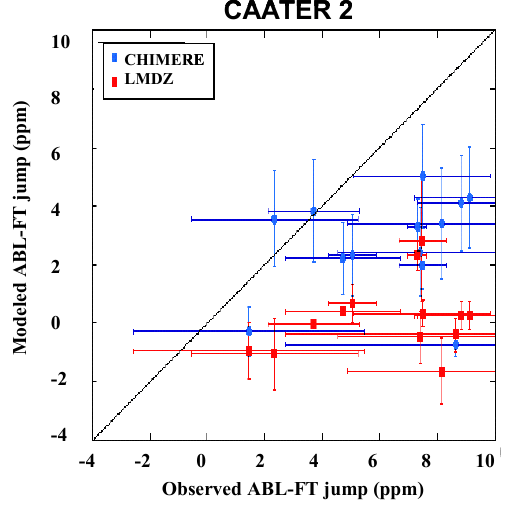
Fig. 6. Comparison of the modelled ABL-FT jumps from LMDZ- ORCHIDEE and CHIMERE-ORCHIDEE to the observed jumps for CAATER 2. Points represent the mean jump for each profile and bars represent the associated ± 1- σ standard deviation from ob- servations and